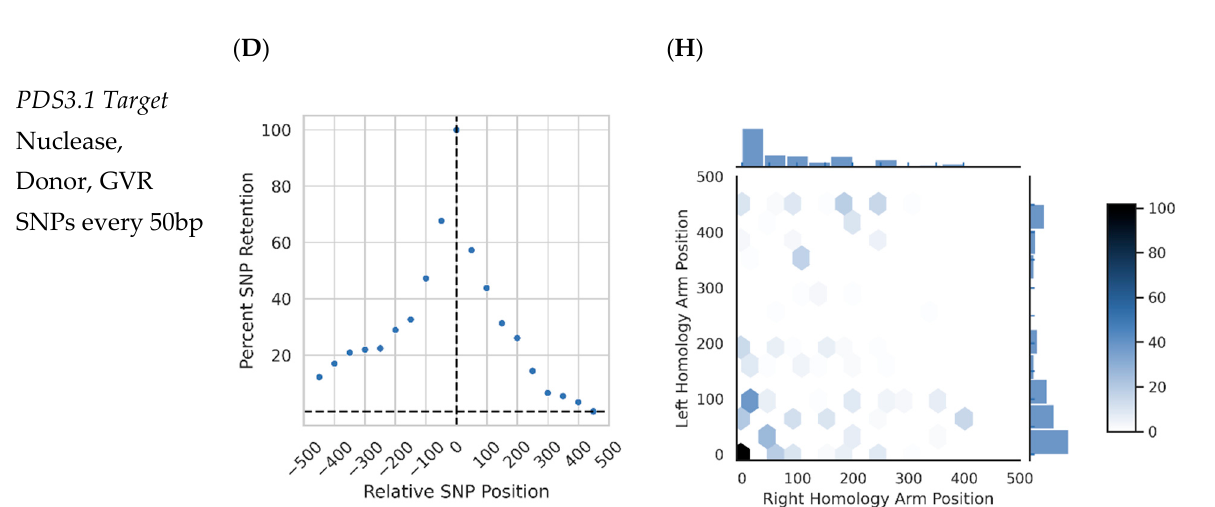
Figure 3. Conversion tracts collected from four gene targeting samples (a representative subset) plotted using two approaches. ( A – D ) Conversion tract diagram showing the percentage of GT reads containing individual donor SNPs. All donor SNPs are represented on the plot and their position relative to the GT insertion is noted on the X axis, with 0 being the GT insertion itself. SNP patterns were ‘smoothed’ to accommodate ONAS error (see text and Figure S1B). ( E , F ) Hexbin plots showing conversion tract patterns in 2 dimensions. Right and Left Homology Arm Position indicate the outermost SNP copied into the target locus from the respective donor arm (right or left). Color intensity indicates the count of events at each position. Axis histograms show relative frequency of conversion tract size for individual arms. ( A , E ) AGAMOUS targeted using a nuclease, GVR, and donor encoding a 3bp insertion with SNPs every 30 bases. ( B , F ) PDS3.1 targeted using a nuclease and donor encoding an 18bp insertion with perfect homology to PDS3.2, an approximately 10% diverged template with an uneven SNP distribution. ( C , G ) As in panels B and F, but with the addition of the GVR. ( D , H ) PDS3.1 targeted using a nuclease, GVR, and engineered donor with SNPs every 50 bp.